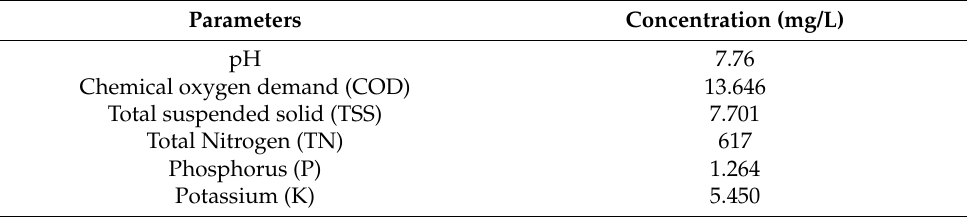
Table 2. Characteristics of anaerobically treated palm oil mill effluent